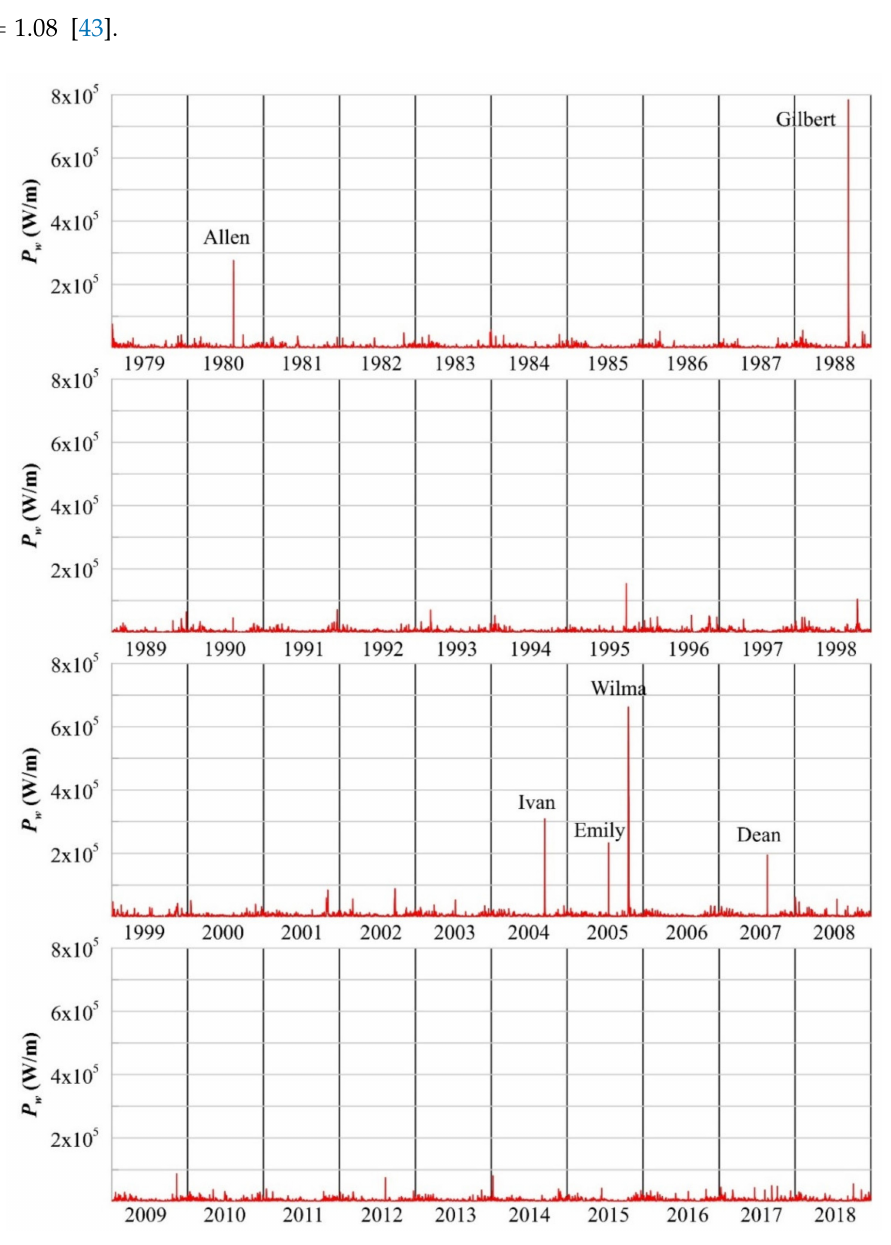
Figure 17. Hourly wave power at 21.0 ◦ N and 86.5 ◦